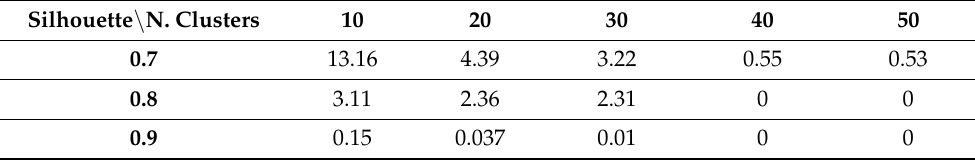
Table 40. Clustering performance in terms of silhouettes using normalized data. Silhouette \ N.